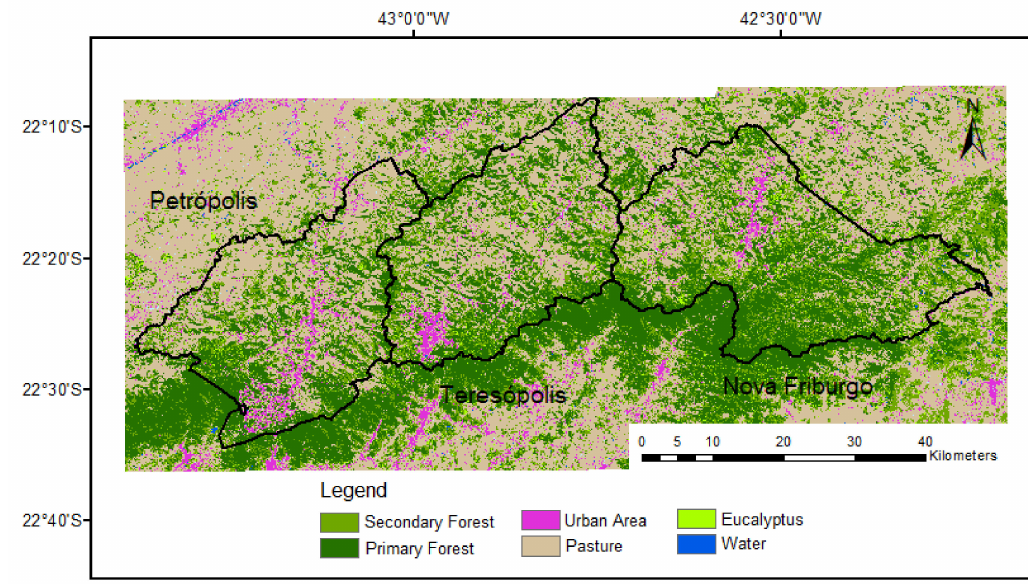
Figure 5. Land use and land cover map in the study